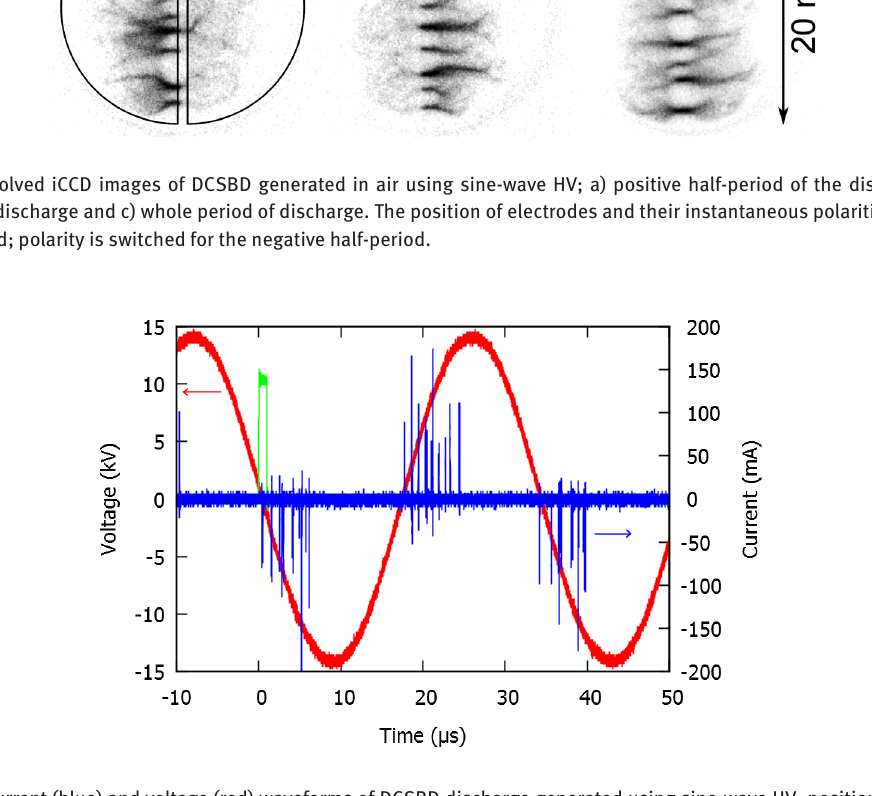
Figure 4 : Typical current (blue) and voltage (red) waveforms of DCSBD discharge generated using sine-wave HV; position of synchronization signal used for synchronization of iCCD camera and digital storage oscilloscope is also given (green).